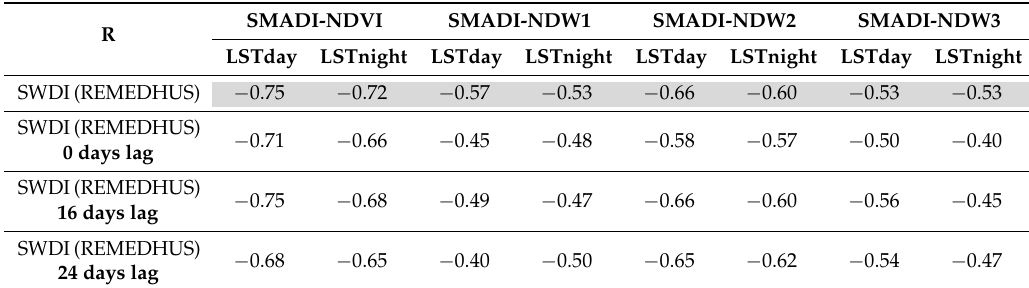
Figure 4a,b show the time evolution and scatter plot of SWDI vs. the SMADI-NDVI-LST day (the case of highest correlations). Both indices show a marked seasonality and reveal the period from winter, 2011 to spring, 2012 as the driest of the series.